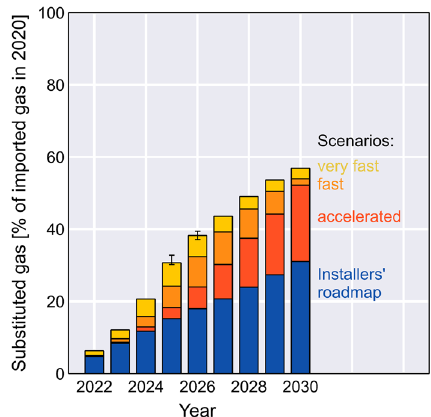
Fig. 5 Gas substitution in Germany by heat pumps. Modelled percentage of imported gas to Germany, substituted by renewable electricity through the installation of heat pumps in private households and in the chemical, paper, and food processing industries, in the four scenarios of Fig. 4. The columns in the background show the amount of gas substituted without installing new heat pumps (by using newly installed PV and wind generation to displace electricity from gas- fi red power plants). The error bar in 2025 indicates the year-to-year weather fl uctuations as standard deviation, the error bar in 2026 the local weather variations within Germany (see Supplementary Note 9). These variations are relatively small and similar in all years. Data are listed in Supplementary Table